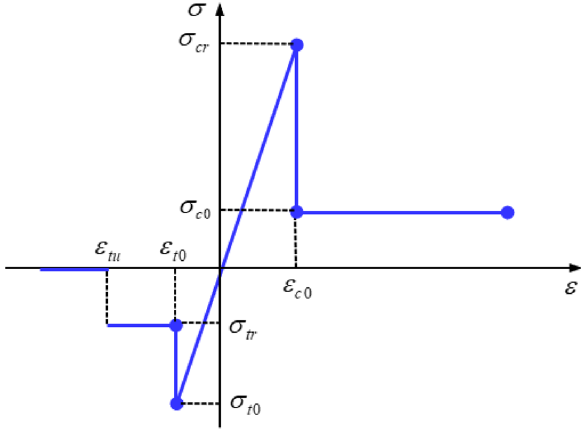
Figure 2. The elastic-brittle constitutive laws of element.